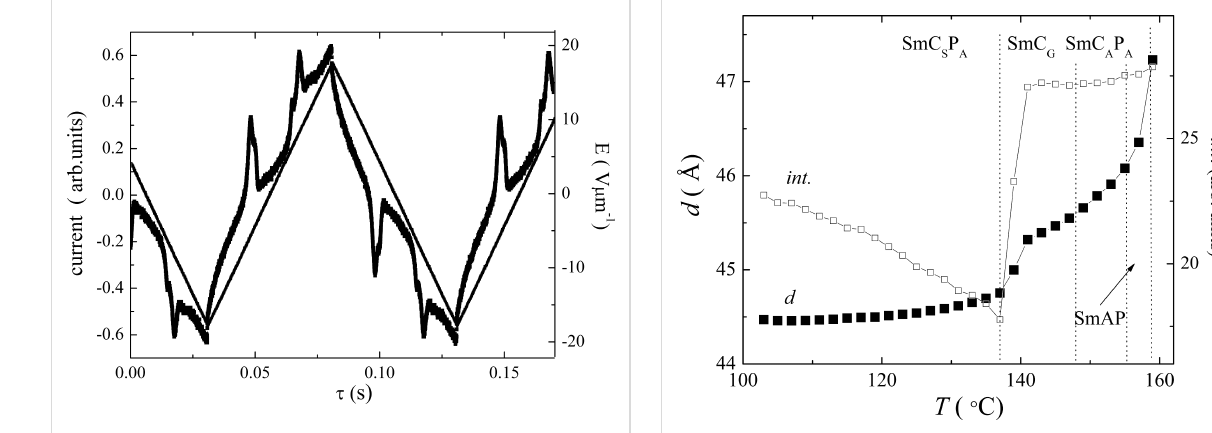
from the in-plane modulation periodicity a, contains about 40 molecules. For comparison the X-ray pattern of the SmC S P A phase at 125 °C is presented in Figure 9b. Regarding the phase assignment, the x-ray patterns in the SmC G phase are different from those characteristic for the B 1Rev phase and resemble more the typical ones for modulated lamellar phases [44,51]. It is consistent with our observations in the modulated SmC G phase, in which the texture does not correspond to the B 1rev phase. For compound IIb the polar fluctuations of molecules have been studied by dielectric spectroscopy. Dielectric measure- ments have been performed in a broad frequency and tempera- ture range. A 3-dimensional plot of the imaginary part of the permittivity is presented in Figure 10.